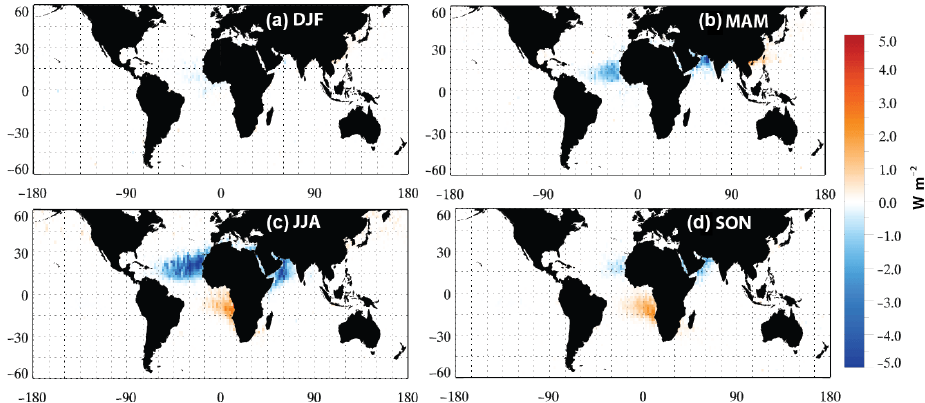
Figure 5. 8-year seasonal mean diurnally averaged shortwave cloudy-sky DRE at TOA, using the CALIOP smoke and OBS dust aerosol models. The ACA AOT in the computation is from the CALIOP operational product without any